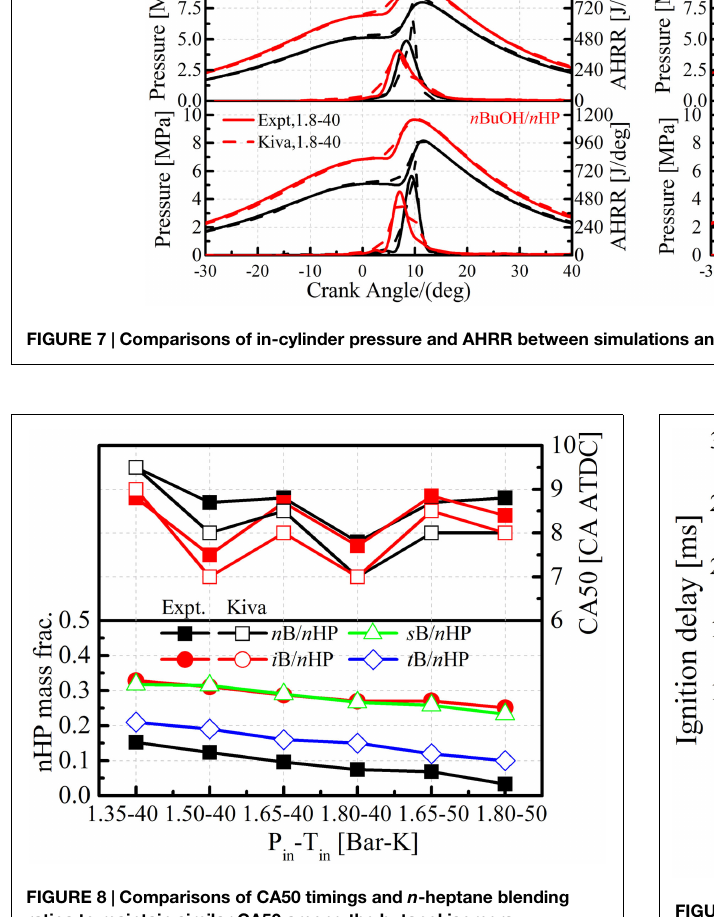
the butanol isomers